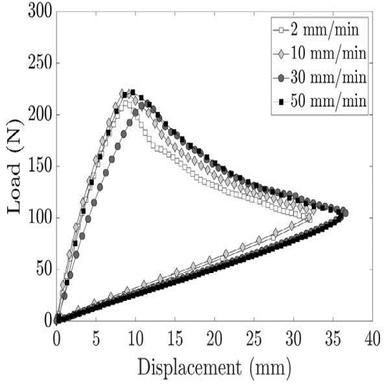
Load-displacement curves from flexible adhesive samples (T2, T3) tested with the DCB test at different displacement rates.